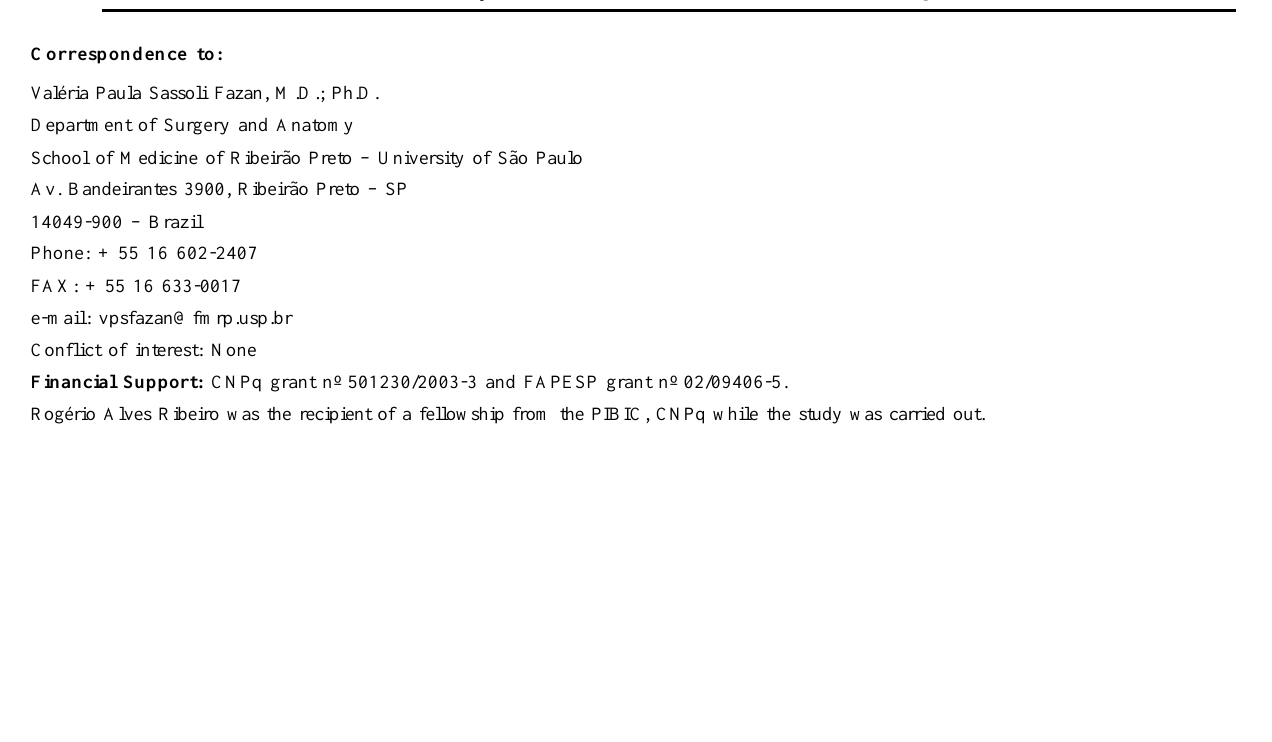
56 - Acta Cirúrgica Brasileira - Vol 18 (Supl. 5) 2003